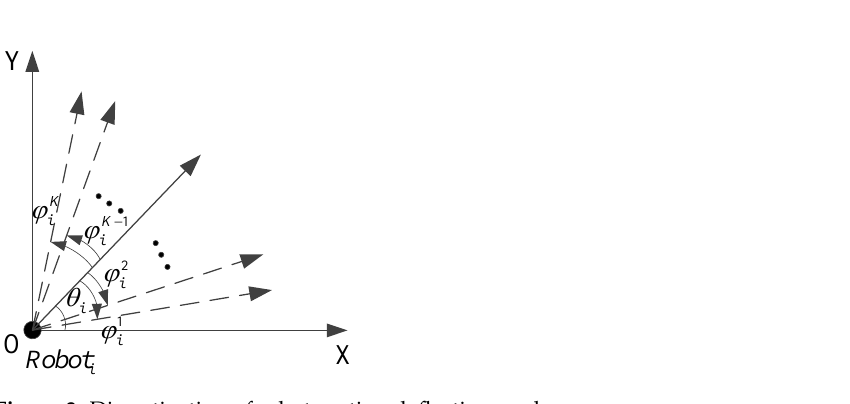
Figure 3. Discretization of robot motion deflection angle.